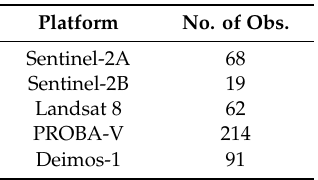
Table 1. Number of cloud-free Libya-4 extractions. Platform No. of